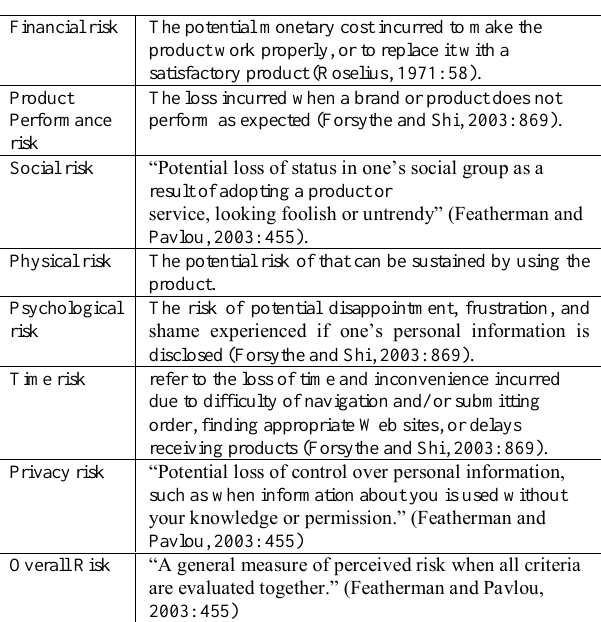
Table 1: Types of